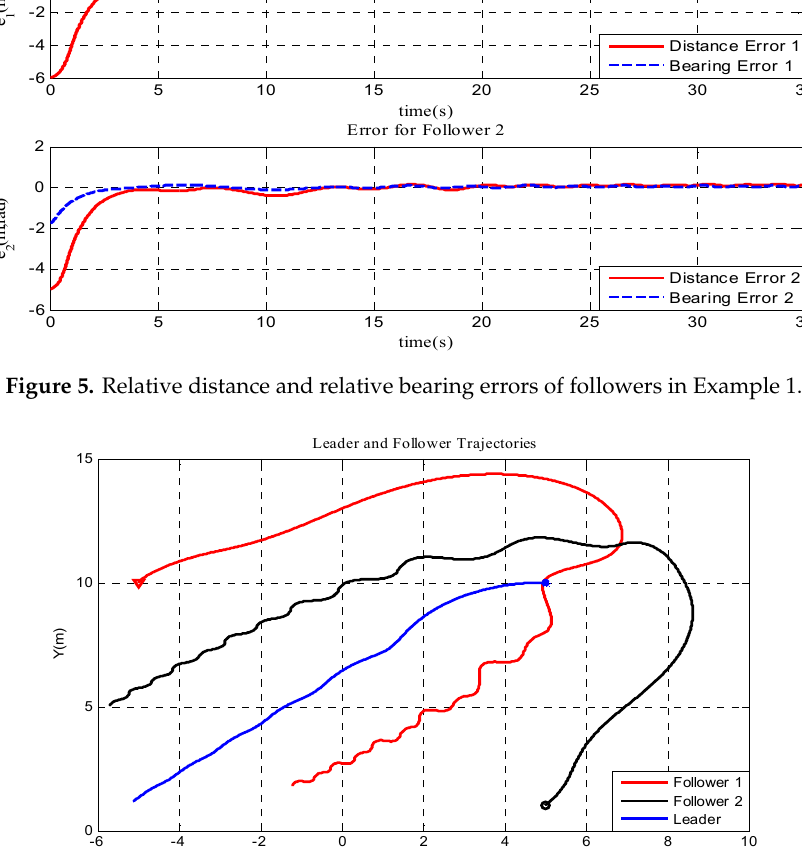
Figure 7. Applied input controls of the first follower in Example 1.